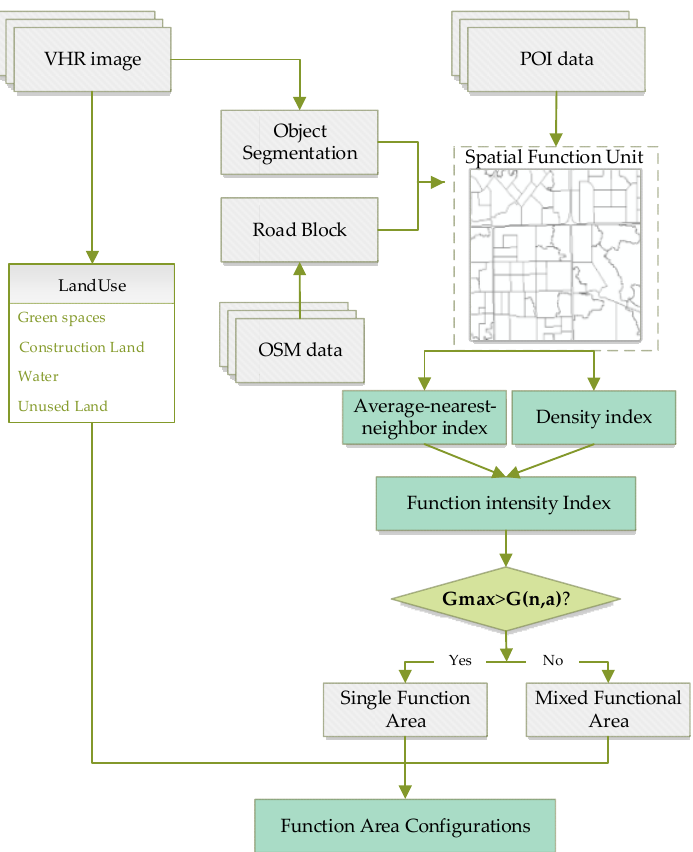
Figure 1. Flowchart of functional-area identification based on POIs and VHR satellite images.